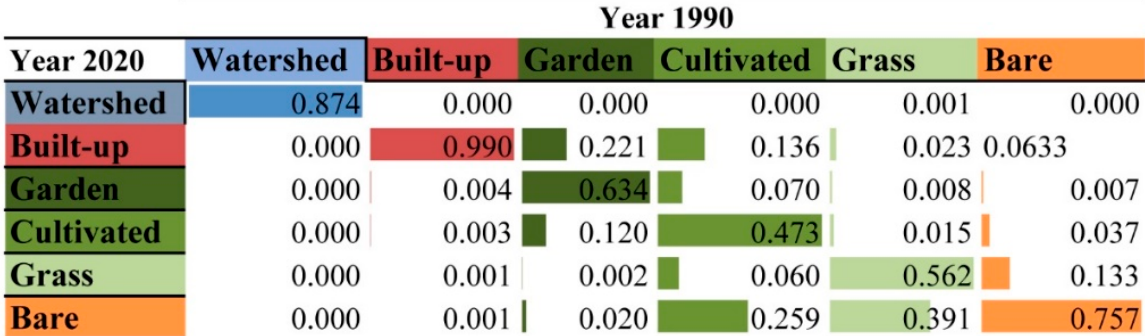
Figure 6. Transition area (Hectares).